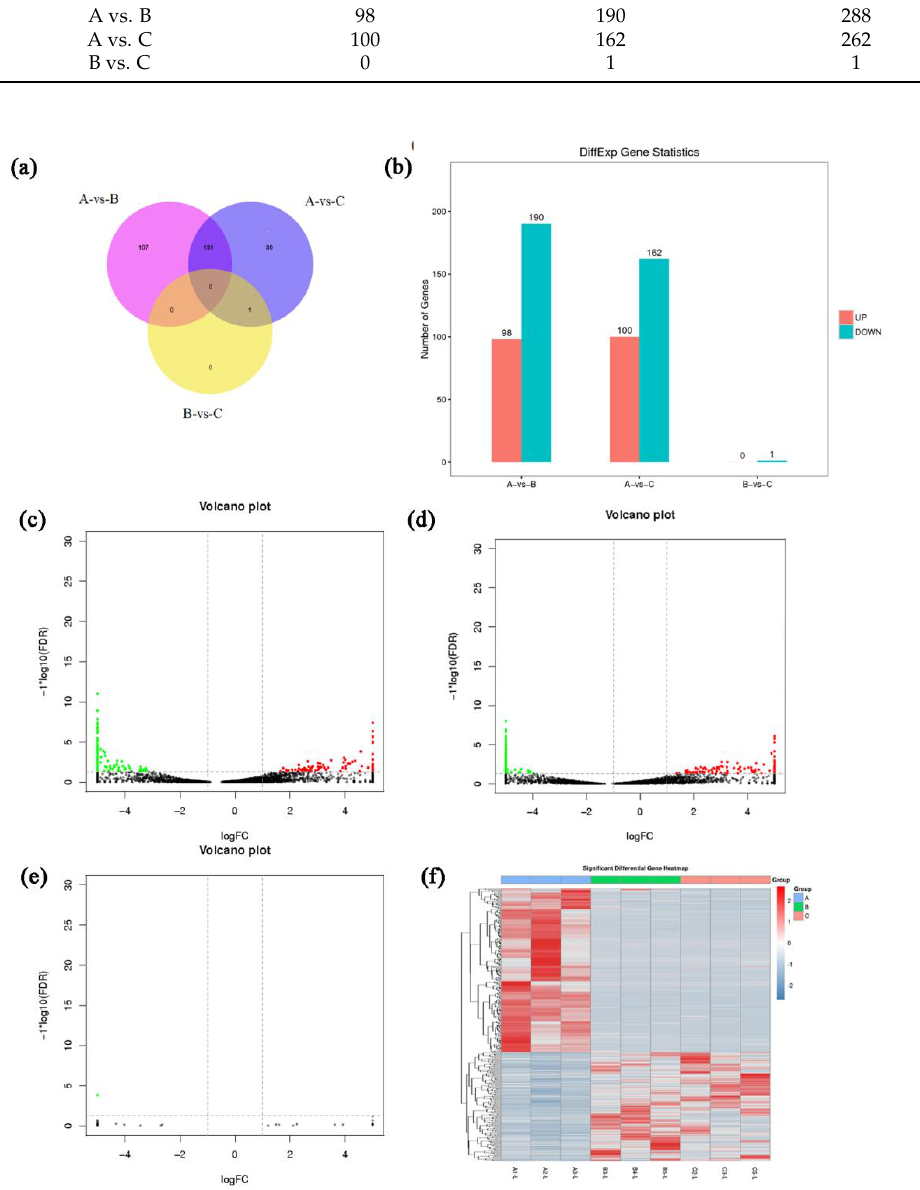
Figure 3. DElncRNA analysis. ( a ) Venn diagram of DElncRNAs in submandibular glands of goats at different ages. ( b ) Histogram of DElncRNAs in submandibular glands of goats at different ages. ( c – e ) Volcano plots of DEcircRNAs in submandibular glands of goats at different ages, red and green color represent up-regulated an down-regulated genes, respectively. ( f ) Cluster analysis of lncRNA expression patterns in submandibular glands of goats at different ages. There were 833, 780, and 86 DEcircRNAs screened between groups A and B, group A and C, and group B and C, respectively. The results are shown in Figure 4 and Table 3. Among all the significantly differentially expressed circRNAs, the top 10 with the most significant differences were significant DEcircRNAs. Type statistics were performed on DEcircRNAs among the groups (Figure 4e). Among groups A and B, and A and C, the main type of DEcircRNAs were annot_exon, followed by intergenic.